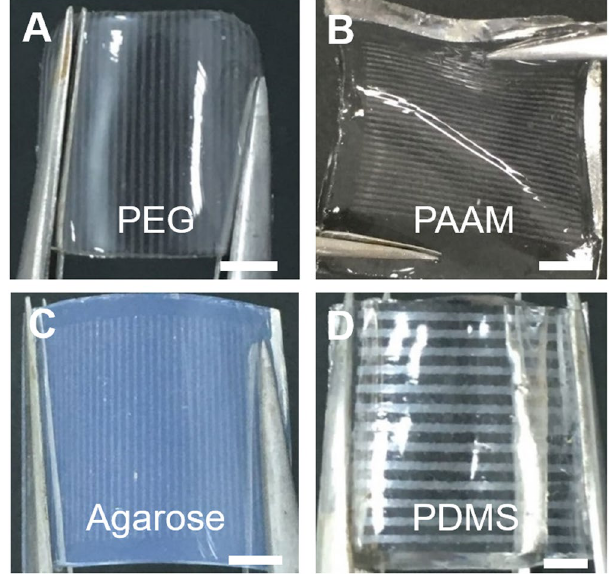
Figure 6. ( A – D ) Photograph images of AgNW-based micropatterns on various hydrogel or elastomer; ( A ) PEG (200 μ m). ( B ) Polyacrylamide (PAAM) (200 μ m) ( C ) Agarose (200 μ m) and ( D ) PDMS (500 μ m). Scale bar: 5 mm.